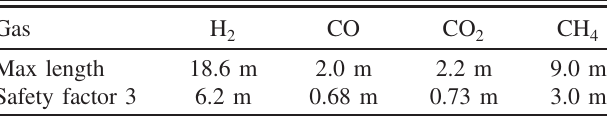
TABLE IX. Maximum length of the interconnect for different gas species, at 40 K.